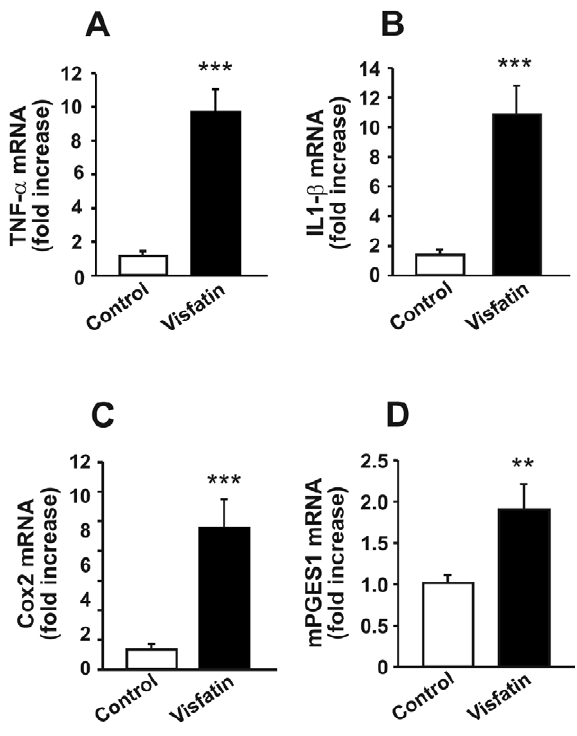
Figure 3. Visfatin-induced increases in hypothalamic mRNA levels of pro-inflammatory cytokines and prostaglandin-syn- thesizing enzymes. RNA was extracted from rat hypothalami 6 h after ICV injection of visfatin. mRNA expressions encoding TNF- a , IL-1 b , COX2 and mPGES-1 were determined using real-time PCR. Visfatin signifi- cantly stimulated the expressions of TNF- a (A), IL-1 b (B), COX2 (C) and mPGES-1 (D) mRNA in the hypothalamus. Data are represented as mean 6 SEM (n=6). **P , 0.01 and ***P , 0.001 vs. control rats injected with 0.9% saline solution.